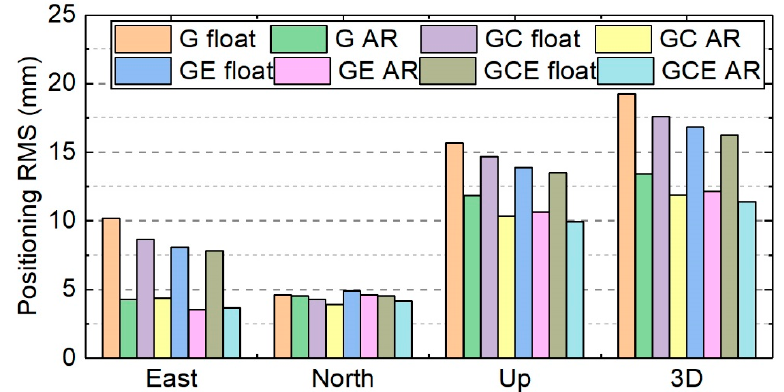
Figure 16. Averaged RMSs of the positioning for “G”, “GC”, “GE”, and “GCE” with float and ambiguity resolution (AR) solutions in the eastward, northward, upward, and three-dimensional (3D) directions for 3 h static PPPs on 3 September 2019.